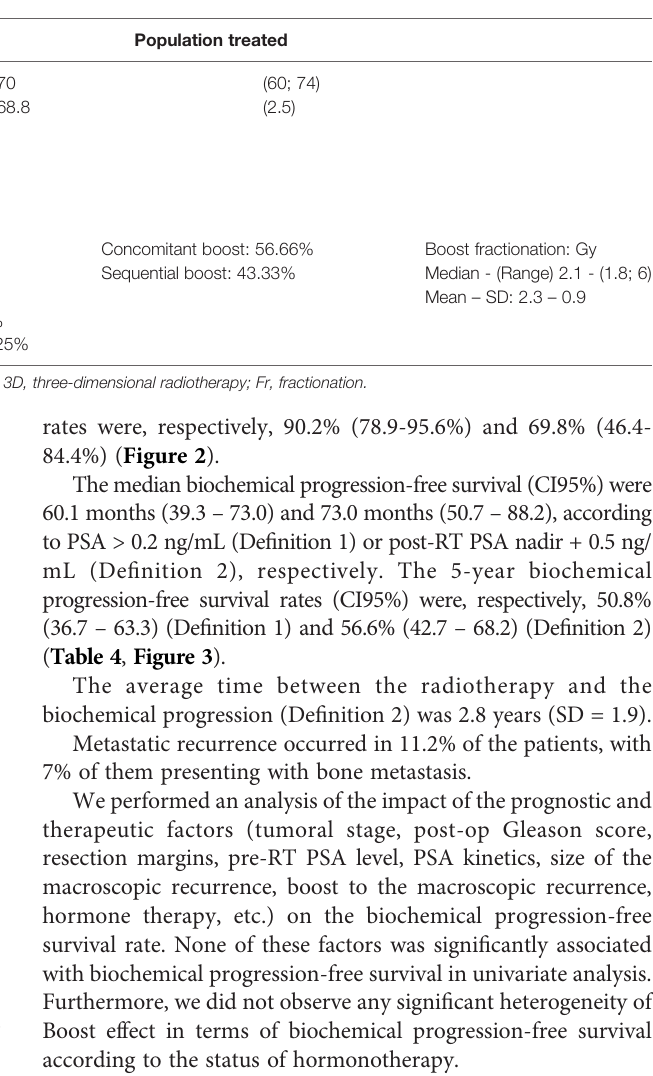
TABLE 3 | Radiotherapy treatment methods.